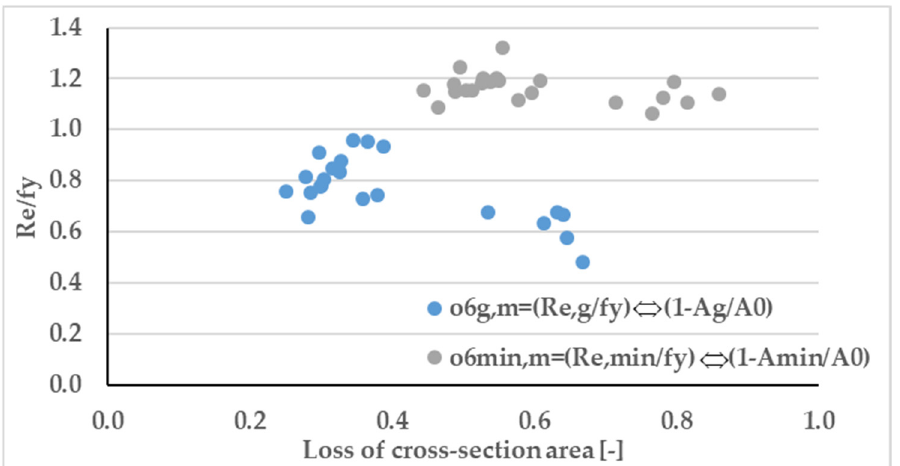
Figure 9. Dependence of the yield strength ratio of the corroded to non-corroded samples (R e,g /f y ) and (R e,min /f y ) on the relevant loss of cross-sectional area of reinforcement ϕ 6 ((1 − A g /A 0 ) or (1 − A min /A 0 )).